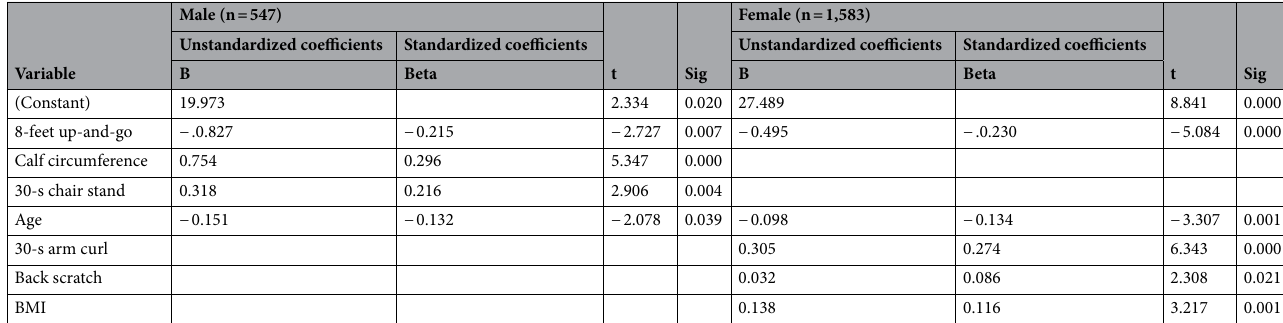
Table 4. Handgrip strength analyzed separately for men and women through stepwise multiple linear regression analysis. Adjusted R-square: men, 0.36; women,